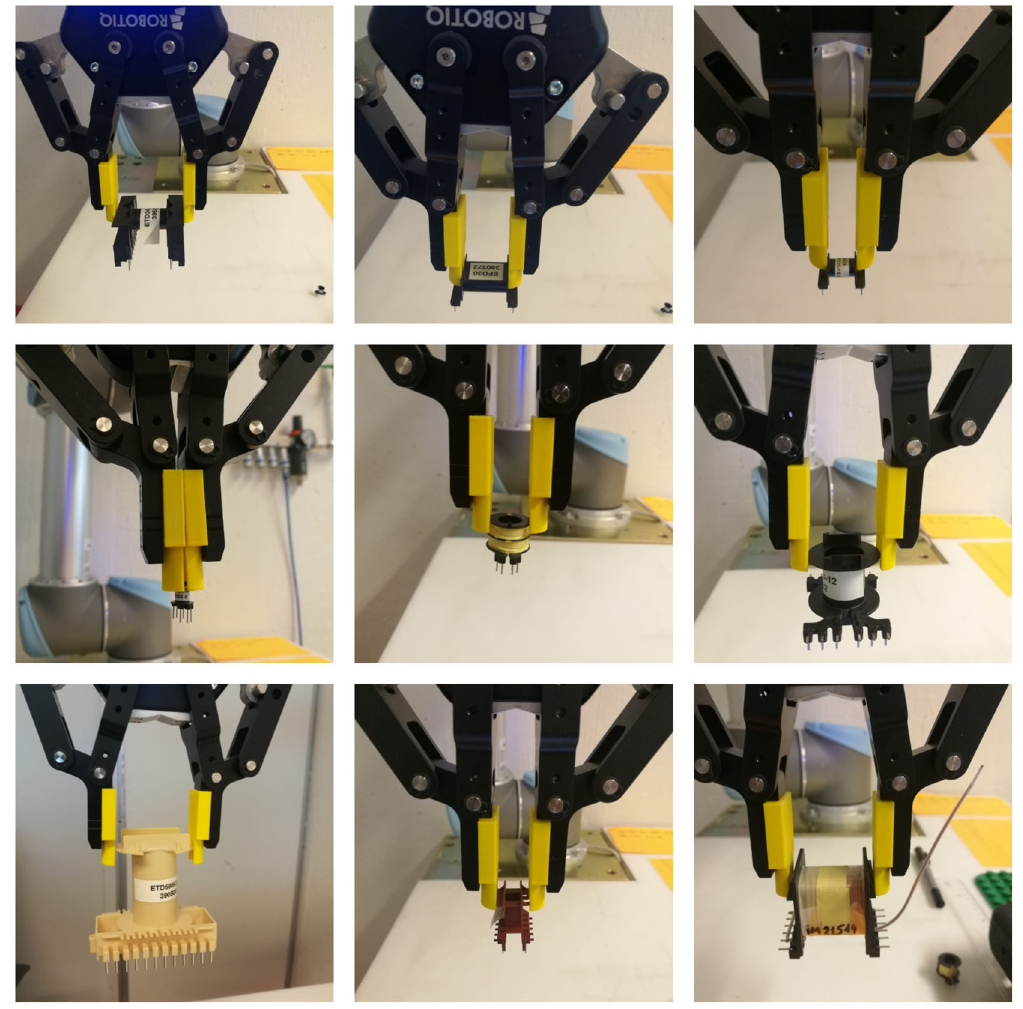
Fig. 9. Universal gripping for the use case using finger modification